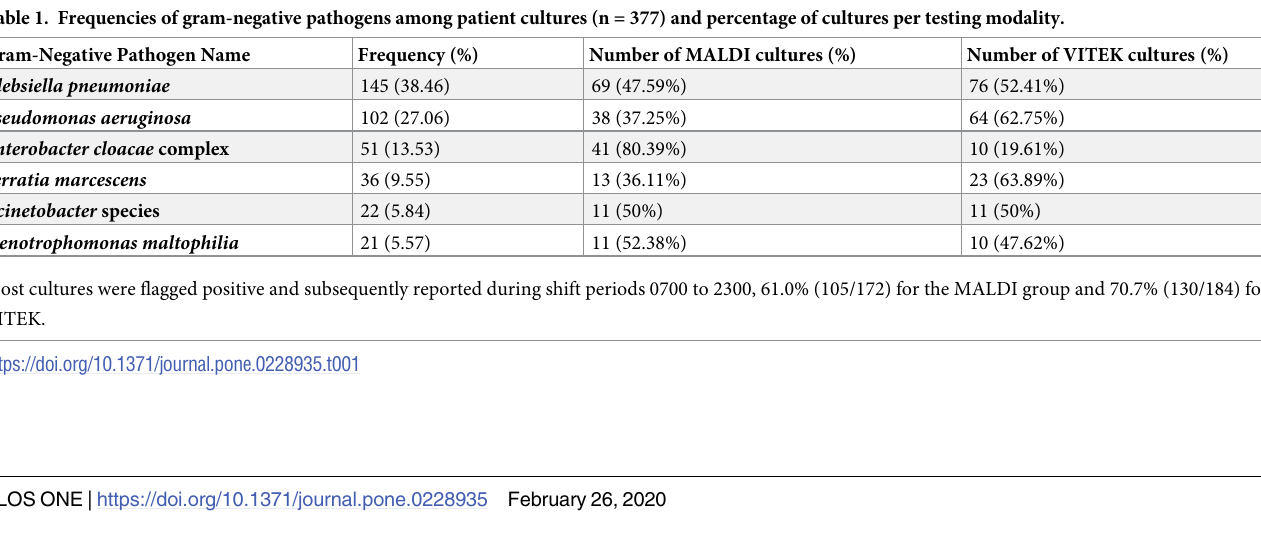
of local resistant patterns. These included, for Acinetobacter baumannii , use of ceftazidime,